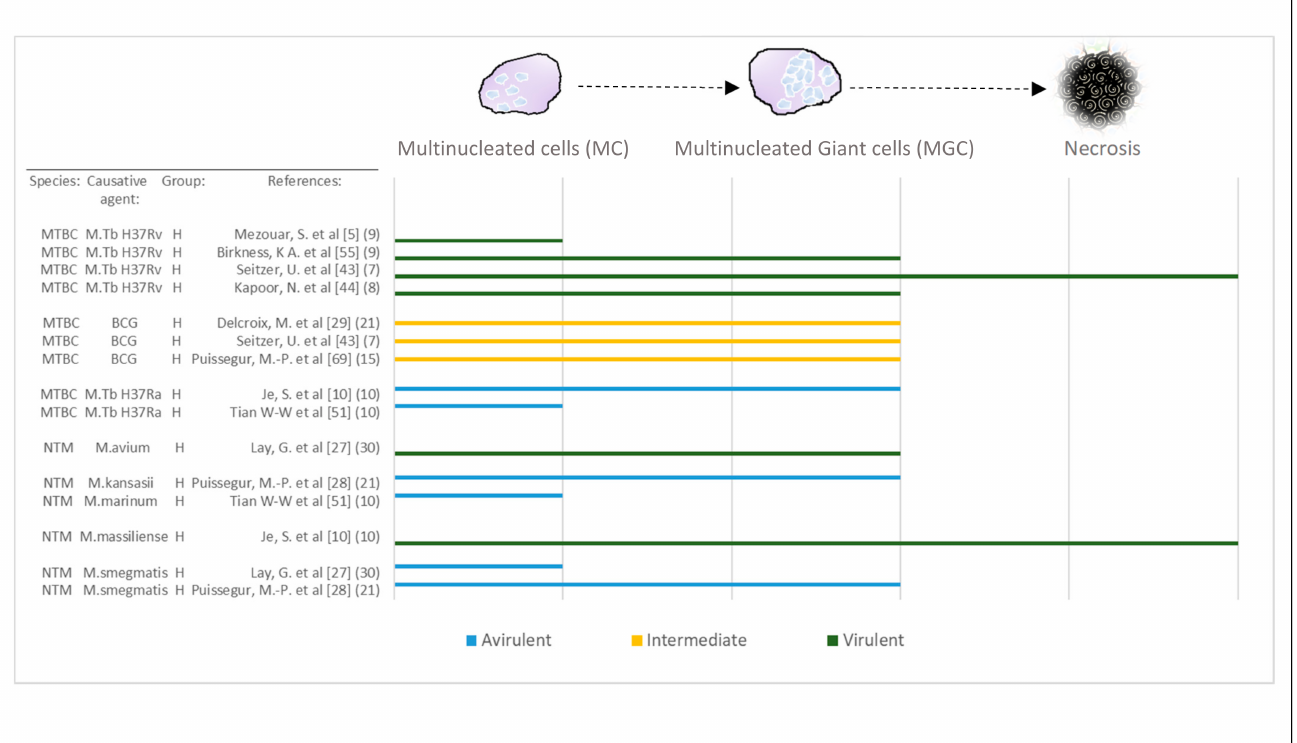
Figure 4. Virulence and late stages of macrophage maturation. Studies that confirmed the presence of MGCs have been selected and recategorized based on the characterization of multinucleated cells (MCs; 2 < number of nuclei < 7) compared with MGCs (number of nuclei > 15). Virulence of mycobacterial species (Table S2) has been evaluated across some of the included studies. In two of these studies, increased virulence was associated with necrosis observed in vitro and MGC formation was observed with avirulent or intermediate species. The remainder of studies did not manage to observe necrosis in culture but confirmed that virulence of species could be differentiated based on either MC or MGC formation. Abbreviations—MTBC: Mycobacterium tuberculosis complex; NTM: non-tuberculous mycobacterial species, H: healthy; BCG: Bacillus Calmette–Gu é rin. [Reference number] per study are included in brackets. Number in brackets refer to length of exposure (days) per